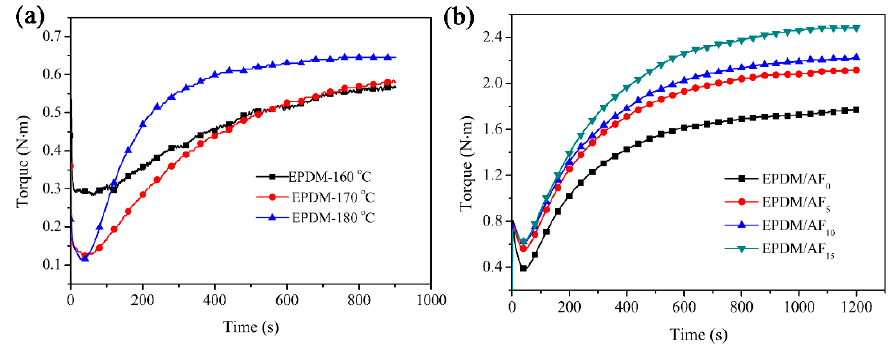
Figure 1. Curing curves of the pure EPDM ( a ) and ceramifiable EPDM composite ( b ). Table 2. Curing characteristics of pure EPDM at different temperatures.